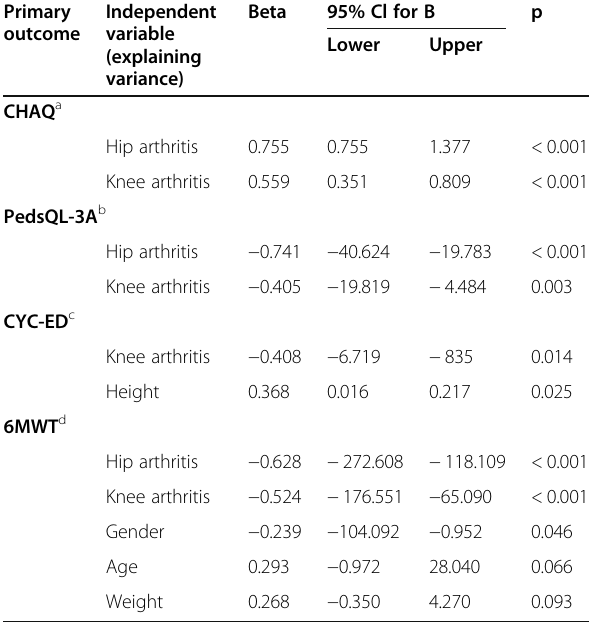
Table 3 Predictors of CHAQ, PedsQL-3A, CYC-E, and 6MWT found in backward regression